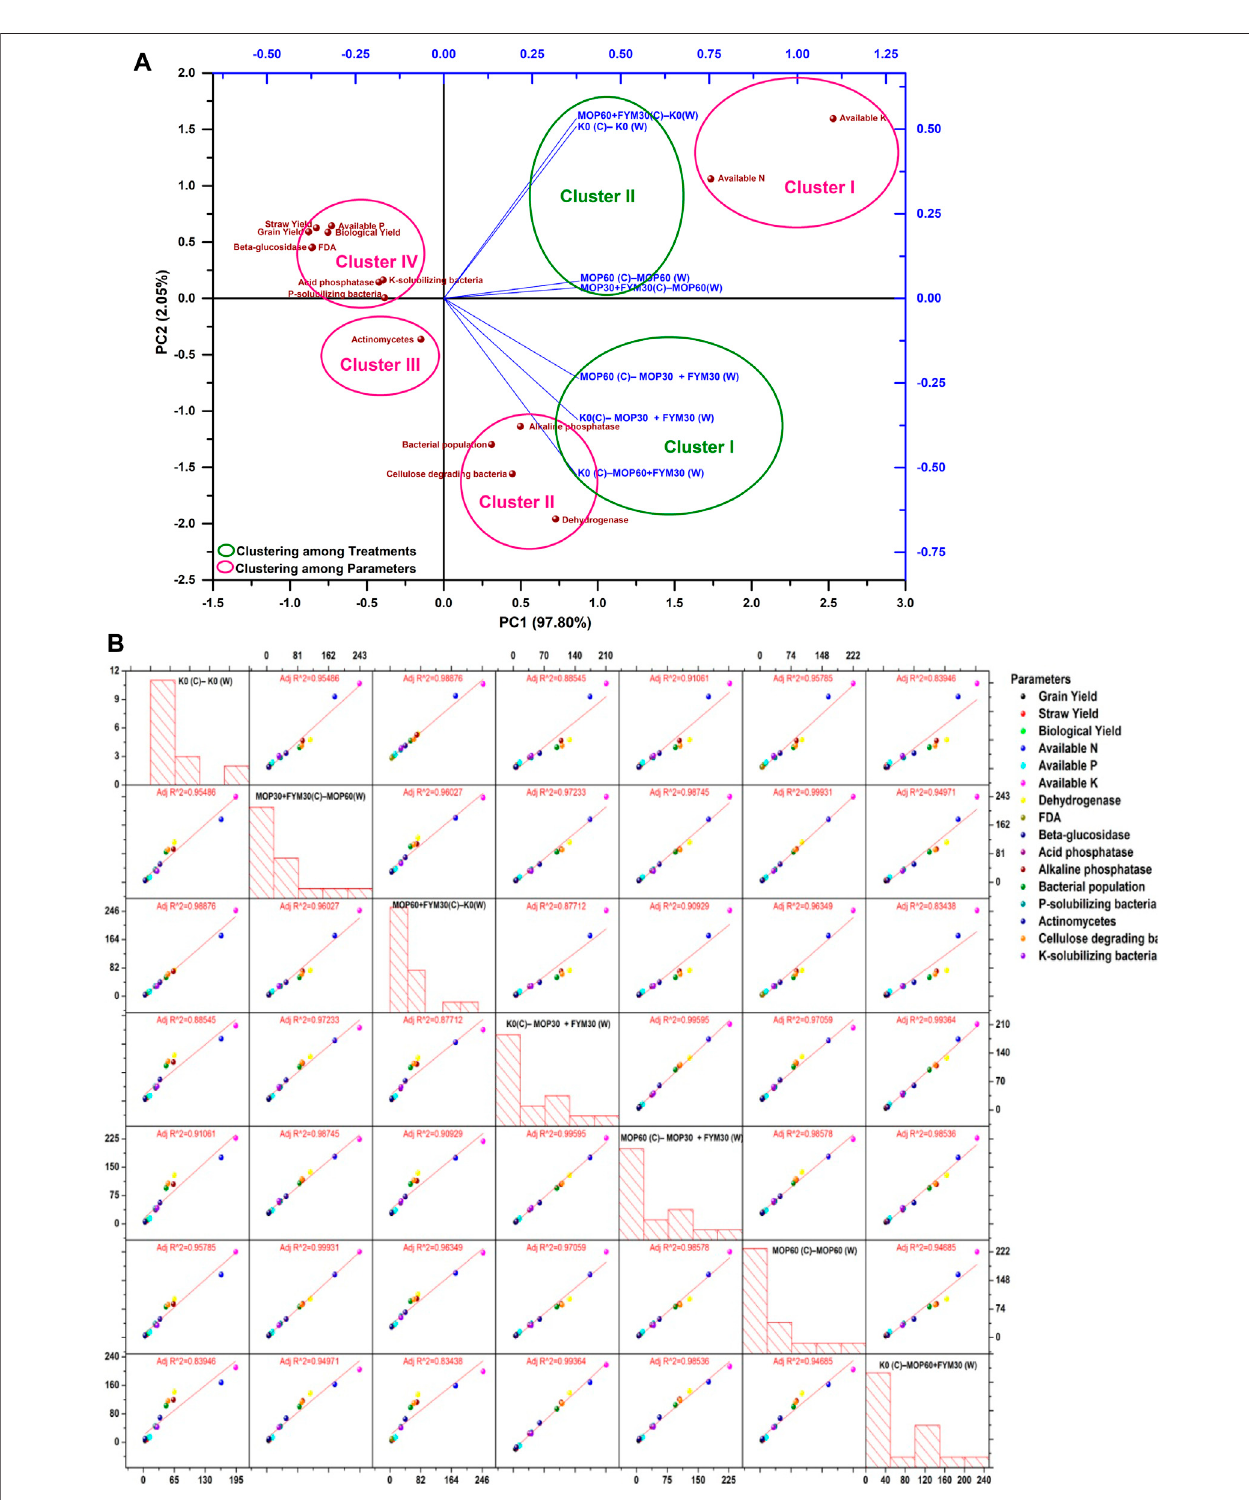
FIGURE5|(A) Principal componentanalysisamongvarious parametersand treatments inthe fi rst year ofwheat cultivation. (B) Scatter plotmatrix and regression analysis among various parameters and treatments in the fi rst year of wheat cultivation.